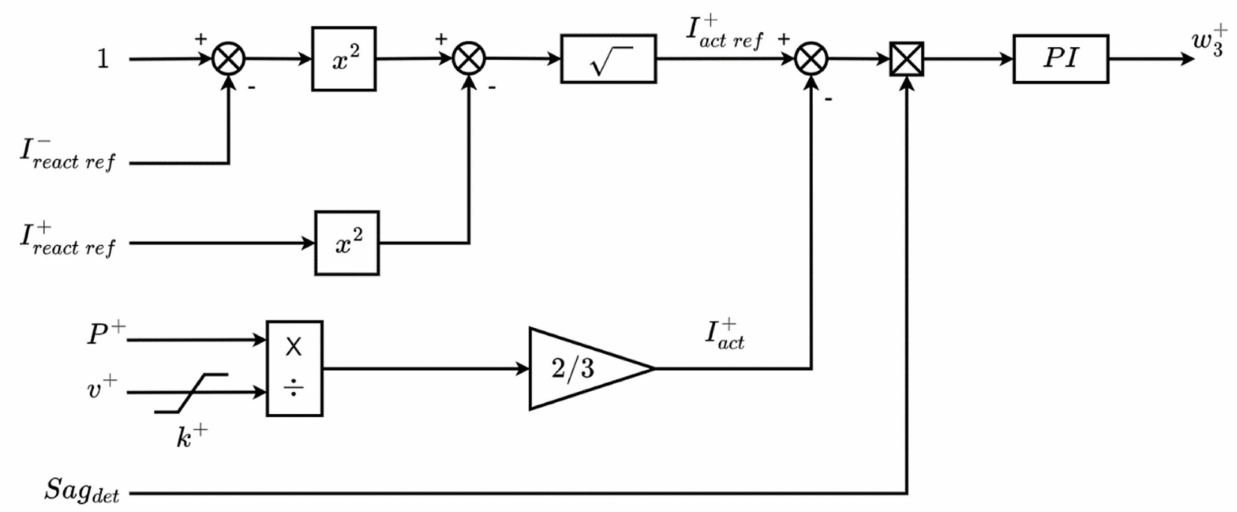
Figure 6. Positive active current controller